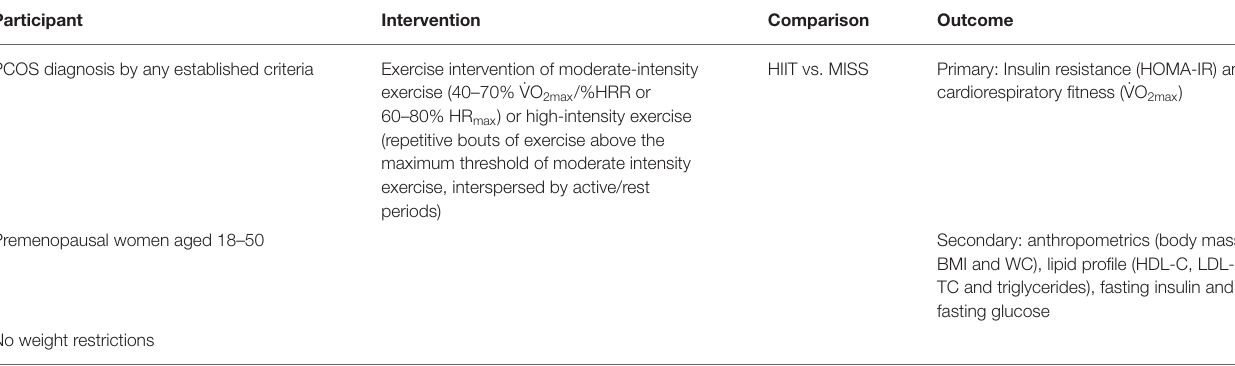
TABLE 1 | Population, interventions, comparators, outcomes and study designs framework. Participant Intervention Comparison Outcome PCOS diagnosis by any established